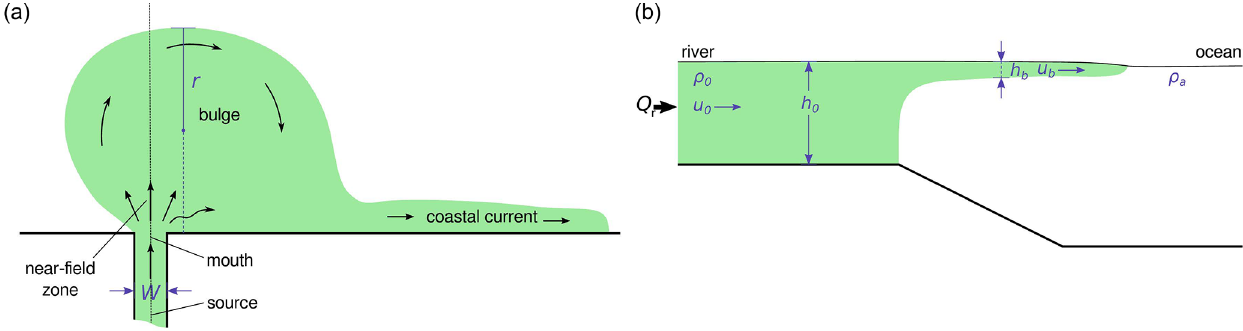
Figure 1. A sketch of the river–ocean dynamical system. (a) Prototypical plume structure. (b) Vertical cross section marked by the black dashed line in panel (a)